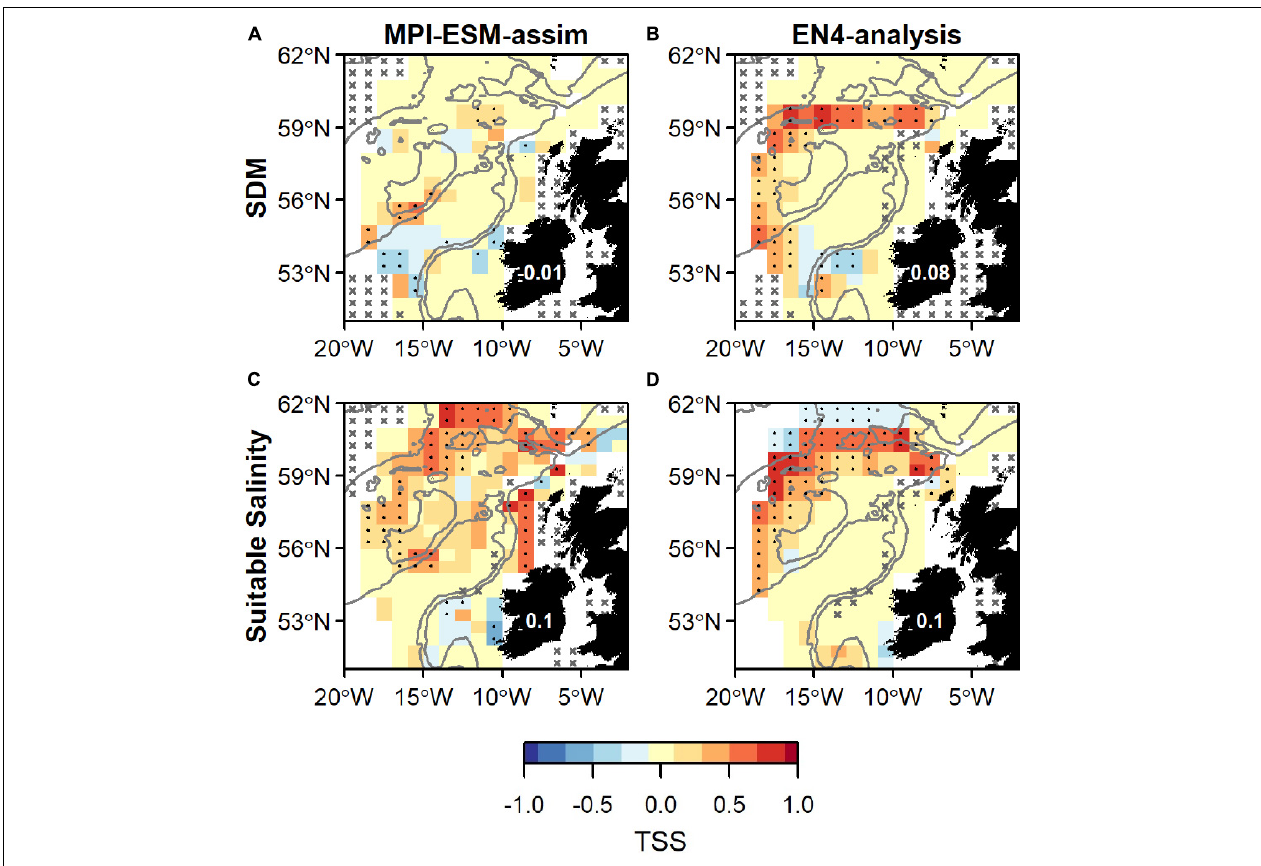
FIGURE 9 | Agreement between the suitable spawning habitat and observations of adult blue whiting from the IBWSS survey in terms of the True Skill Statistics (TSS) during March and April. The suitable spawning habitat is defined through Species Distribution Models (SDM) (top row; A,B ) or the suitable salinity for spawning (bottom row; C,D ) and based on MPI-ESM-assim (left; A,C ) and EN4-analysis (right; B,D ). In a and b the best performing SDMs ( Table 3 ) were chosen: SDM_ST MPI (A) and SDM _ S EN4 (B) . Dots show significant correlations at the 95% confidence level and crosses indicate regions where the predictive skill cannot be evaluated confidently due to sparse observational data, both based on a 500-fold bootstrap. Good predictive quality (TSS > 0) is indicated by red colours (where HR > FAR) and the mean TSS within the plotted region (excluding regions with crosses) is noted on Ireland. The grey lines indicate the 600 m and 2,000 m